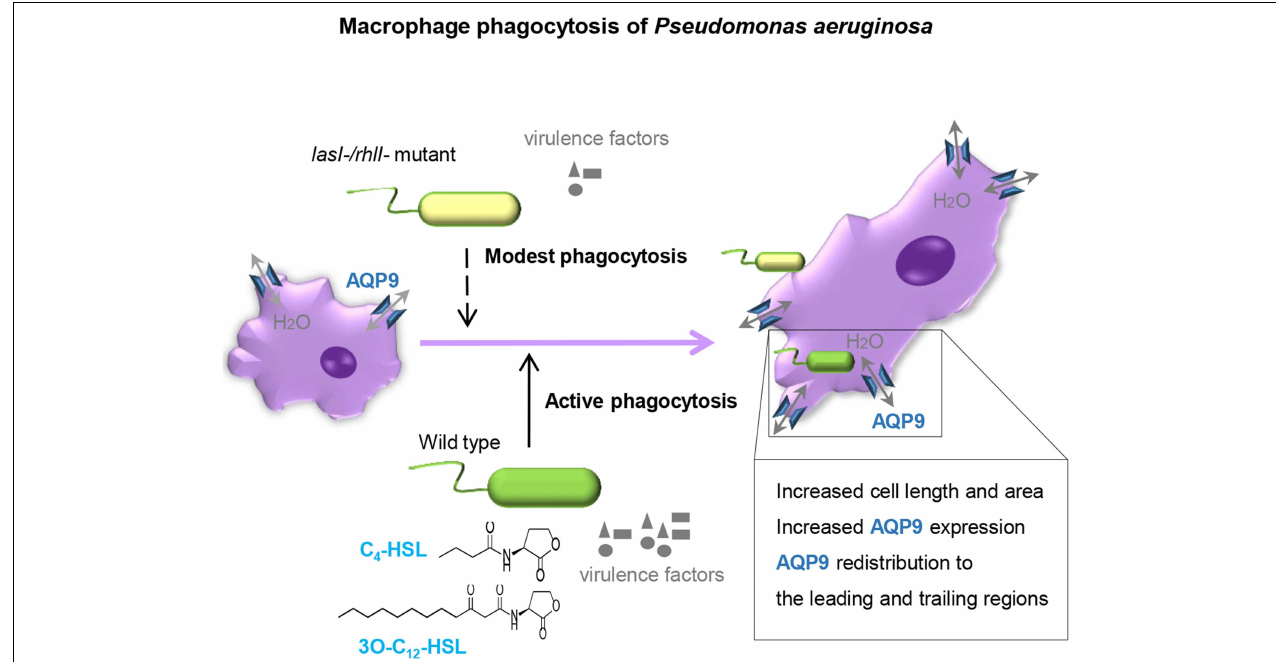
FIGURE 8 | Proposed model. P. aeruginosa lasI / rhlI quorum sensing genes promote phagocytosis and AQP9 redistribution to the leading and trailing regions in macrophages. The phagocytosis of P. aeruginosa by macrophages seems more effective when QS genes lasI and rhlI responsible for synthesis of two QS molequles 3O-C 12 -HSL and C 4 -HSL and associated virulence factors are fully functional. Moreover, the P. aeruginosa infections results in elevated AQP9 expression and relocalization to the leading and trailing regions in macrophages, increased cell area, and length; here, bacteria with a functional QS system lasI/rhlI achieved stronger